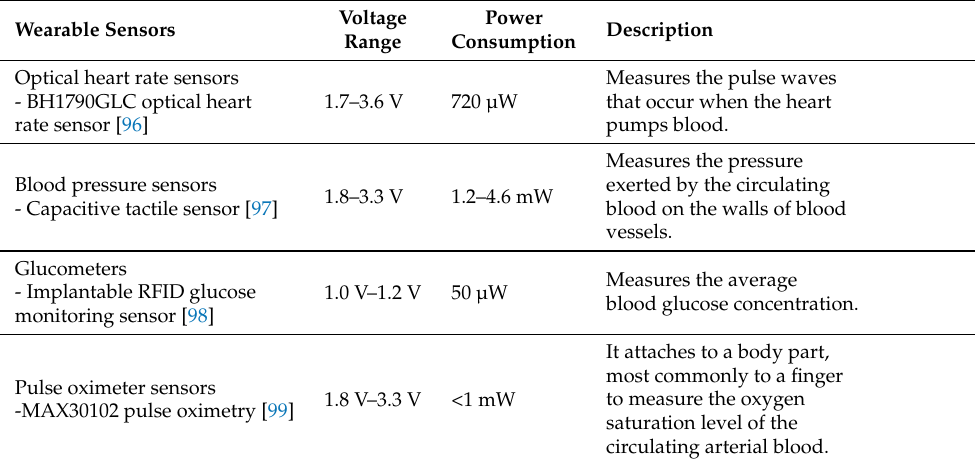
Table 5. Energy consumption of typical medical